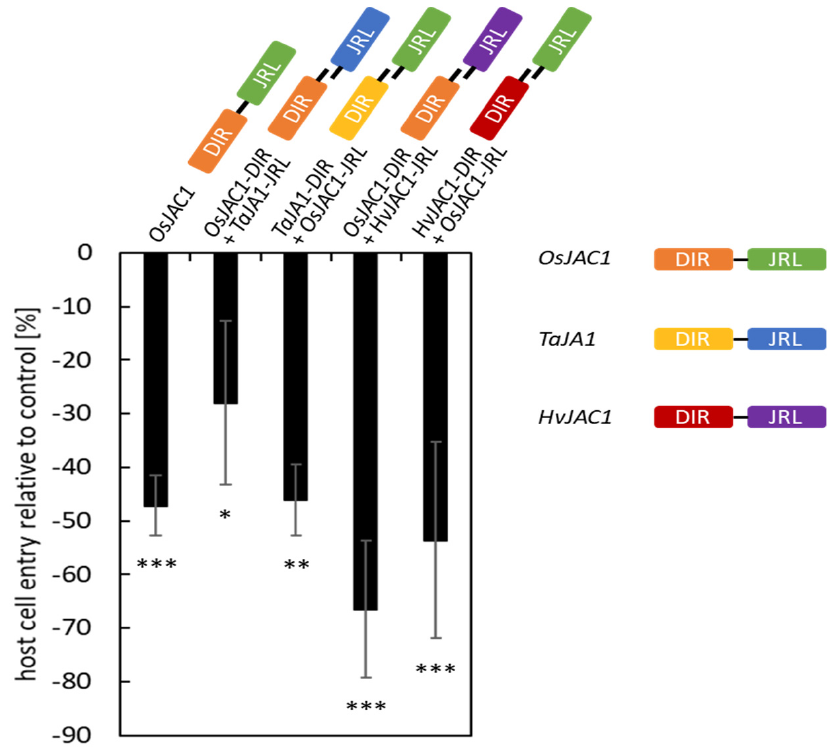
Figure 1. Domain-swap experiment with DIR and JRL domains of chimeric proteins from rice, barley, and wheat. Primary leaves of barley were transiently co-transformed with constructs encoding for the artificially separated domains of Os JAC1, Ta JA1, and Hv JAC1. At 48 h p.i., the effect of overexpression on the penetration success of Bgh was evaluated. Host cell entry rates were determined from the ratio of sites with successful penetration to the total number of interaction sites of spores with transformed cells. The negative control (empty vector) was set to 100%, and significant differences were determined using one-way ANOVA and are labeled with asterisks ( P < 0.05: *; P < 0.01: **; P < 0.001: ***). The bars represent the mean values of at least three experiments with 50 to 300 evaluated interaction sites on three leaves ( n = 3) ± standard deviation. For visualization, the values of the control are taken as baseline (equal to “0%”) and, hence, the negative values for the test candidates can be read intuitively as a reduction in penetration